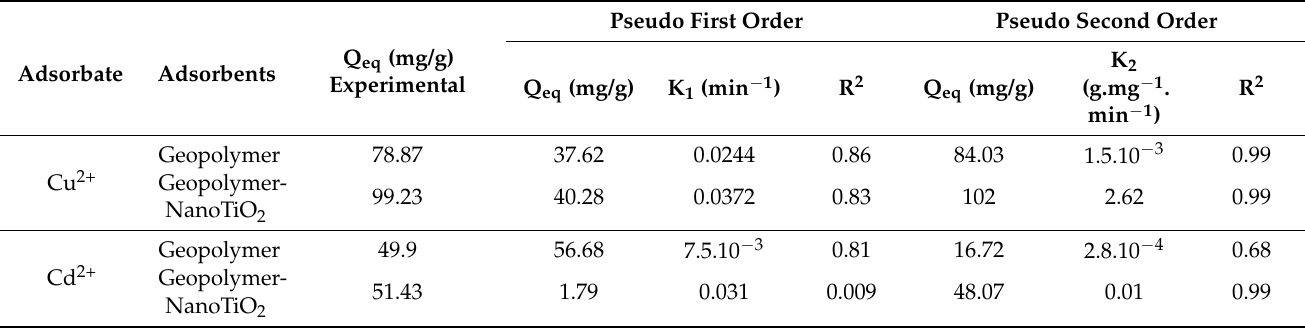
Table 2. Pseudo-first-order kinetic model and pseudo-second-order kinetic model